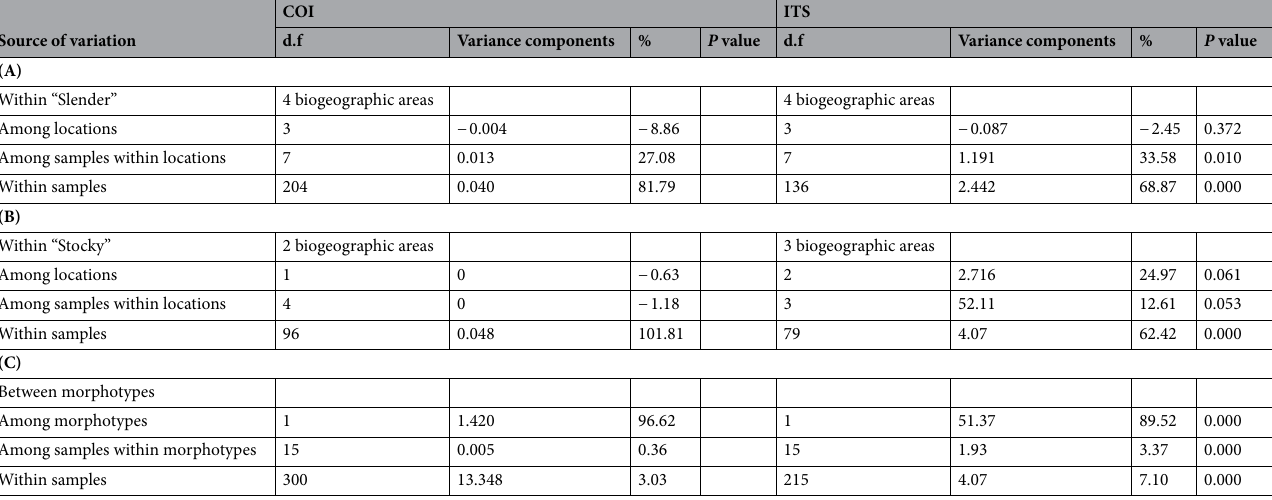
Table 2. Results of the analysis of molecular variance (AMOVA). For each marker groups were defined according to biogeographic areas (A) within the “Slender” morphotype; (B) within the “Stocky” morphotype and (C) between morphotypes (d.f.: degrees of freedom; % var: percentage of